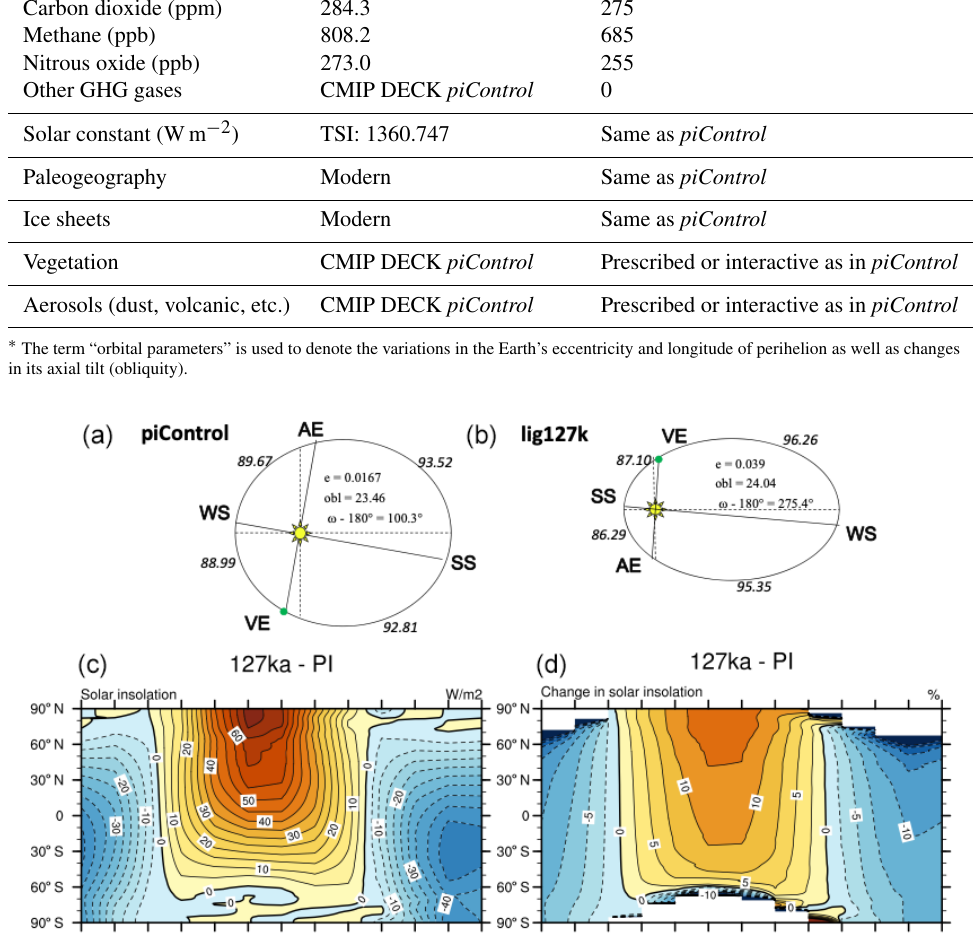
from their minimum levels during the previous glacial pe- riod to values comparable to, albeit somewhat lower than, preindustrial levels (Table